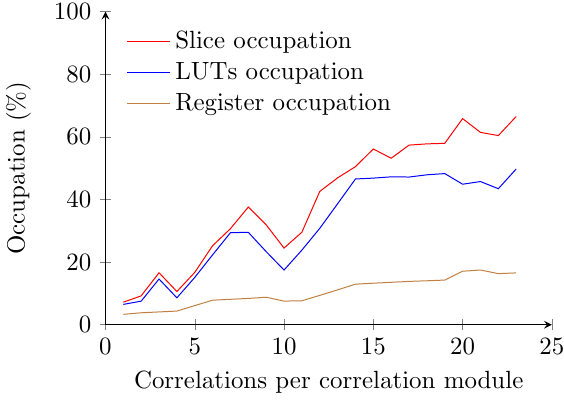
Figure 11. Occupation of the receiver using the naive correlator implementation. The graph covers a range from one correlation per correlation module up to 23 correlations per correlation